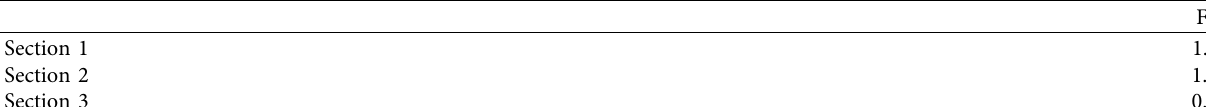
Table 3: FOS after applying seismic conditions in LEM.